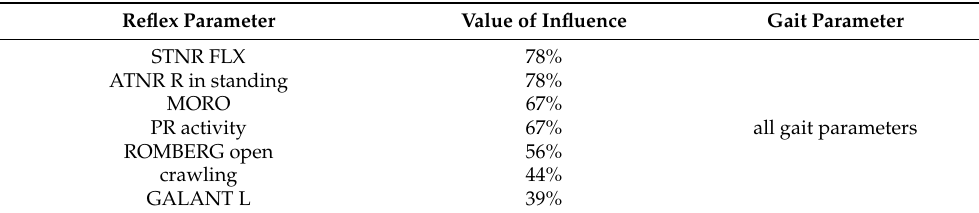
Table 2. Distribution of frequency in the influence of gait parameters by some of the examined reflex factors.